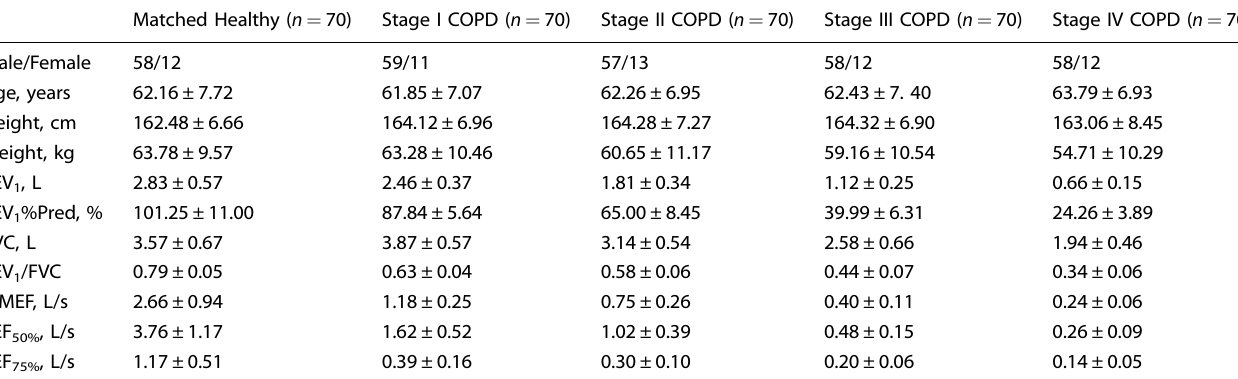
Table 2. Demographic characteristics and spirometric parameters (mean ± standard deviation) of COPD patients and matched healthy subjects.